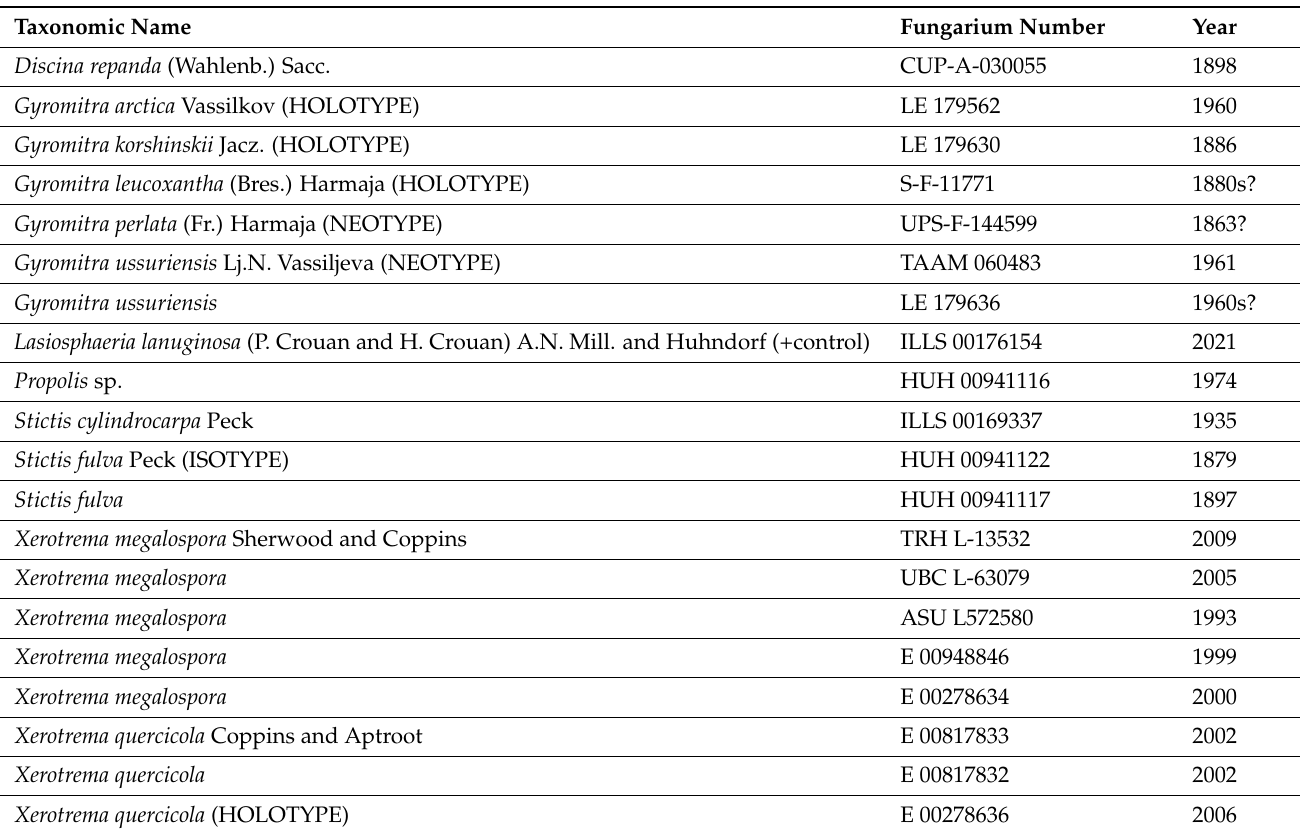
Table 1. Samples used in this study with taxonomic name, fungarium number, and year the specimen was